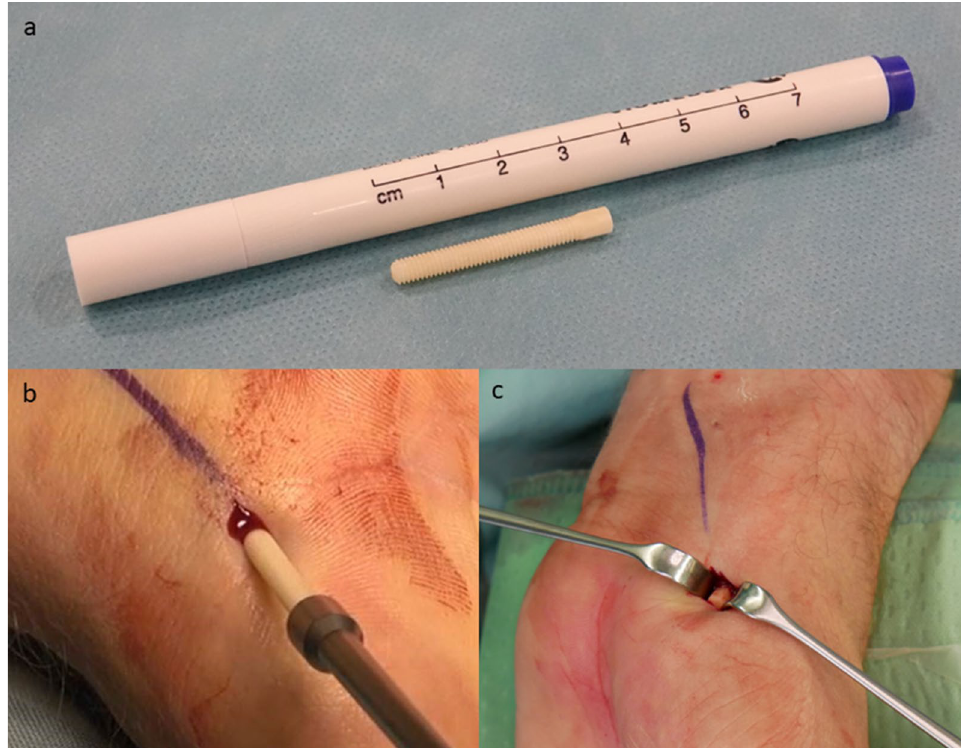
Fig. 1 Bone screw and surgical procedure. A Example of the cortical bone screw. B The Shark Screw ® "cut" is screwed in, without much resistance, with a hexagonal screwdriver. C The skin incision was pulled proximally with a narrow-wound hook and, at the same time, the wrist was bent so that the protruding material of the cortical bone screw could be sawn off just above the bone surface in a subsequent